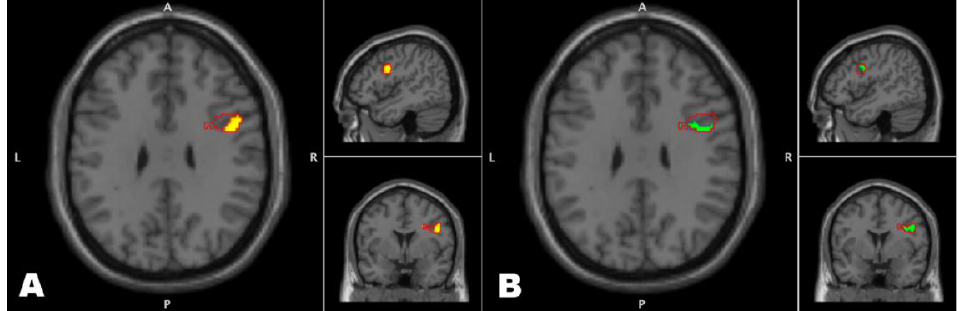
Figure 3. Higher levels of functional connectivity strength of right posterior intraparietal sulcus (IPS) with right precentral gyrus within the FM group were observed to interact positively with pain intensity and HADS scores. This cluster in right precentral gyrus outlined in red is the result of a seed-voxel analysis testing for anxiety and depression HADS score, pain sensitivity and pain intensity with right posterior IPS as seed. The cluster outlined in red was used as an inclusive mask for post-hoc analyses. The left side of the figure, denoted with ( A ), shows in yellow the cluster resulting from a significant positive interaction of pain intensity scores with connectivity of right IPS. The right side of the figure, denoted with ( B ), similarly shows in green the cluster resulting from a significant positive interaction of HADS scores with connectivity of right IPS.